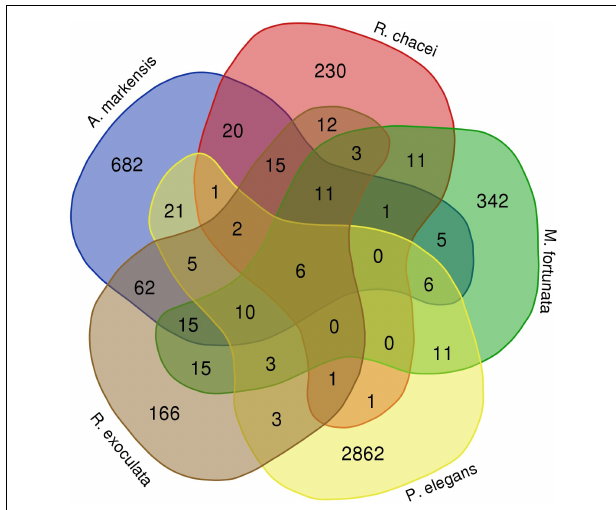
FIGURE 6 | Venn diagram displaying the number of variants shared among the five species from this study. This diagram includes all variants with abundances at least equal to two